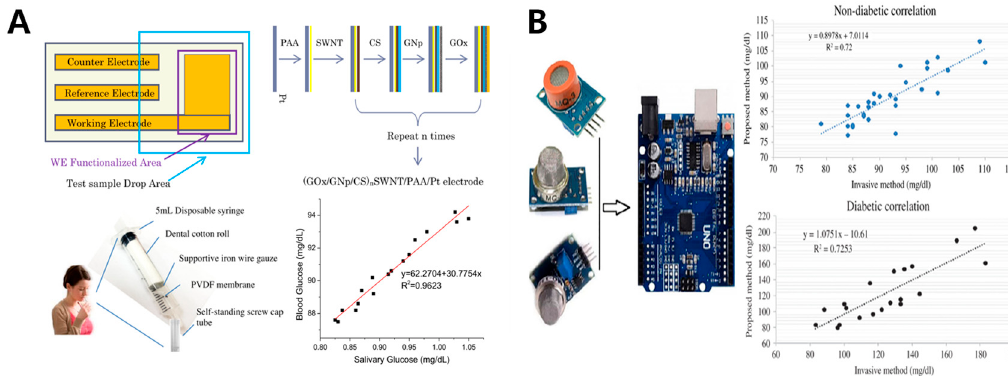
Figure 9. Saliva-based and breath acetone glucose monitoring. ( A ) Non-invasive glucose monitoring using saliva nano-biosensor. Adapted with permission [108]. Copyright 2015, Elsevier. ( B ) Non-invasive measurement of blood glucose by breath analysis. Adapted with permission [129]. Copyright 2020, John Wiley and Sons.